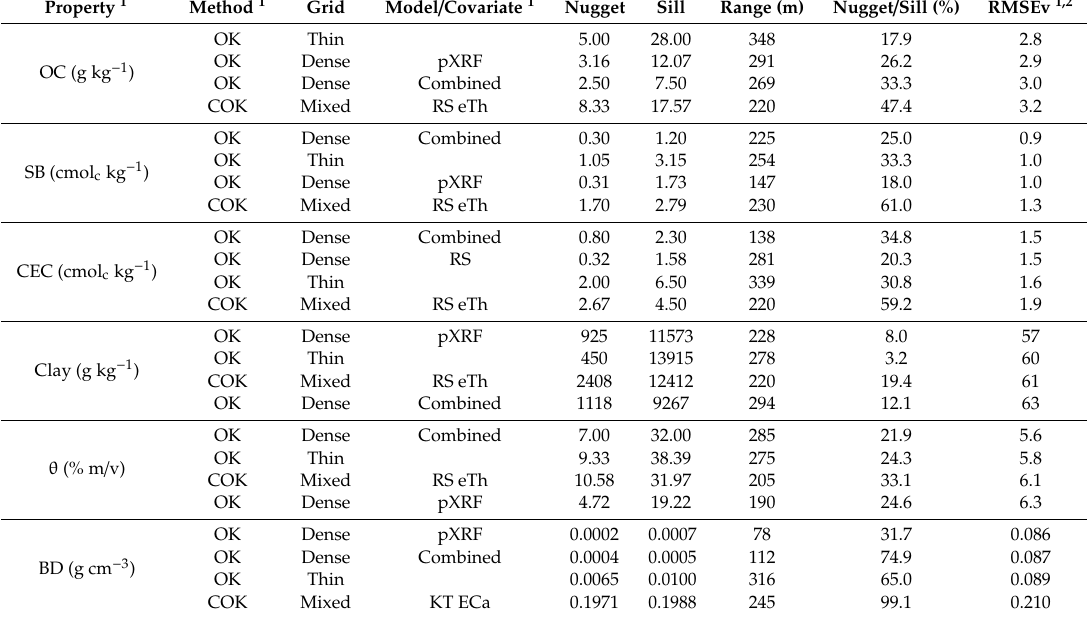
Table 4. Fitted spherical variogram parameters of laboratory soil properties, and external validation errors of produced